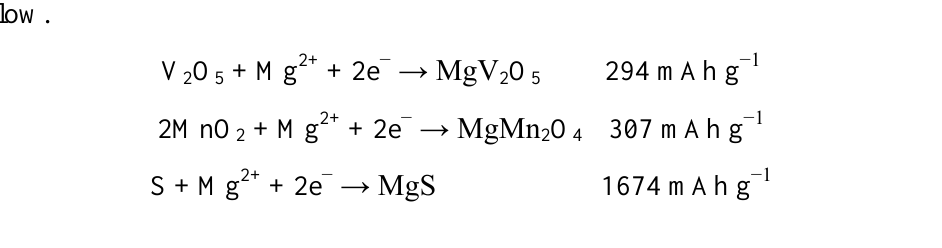
Figure 8. XPS narrow spectra of SMn-V